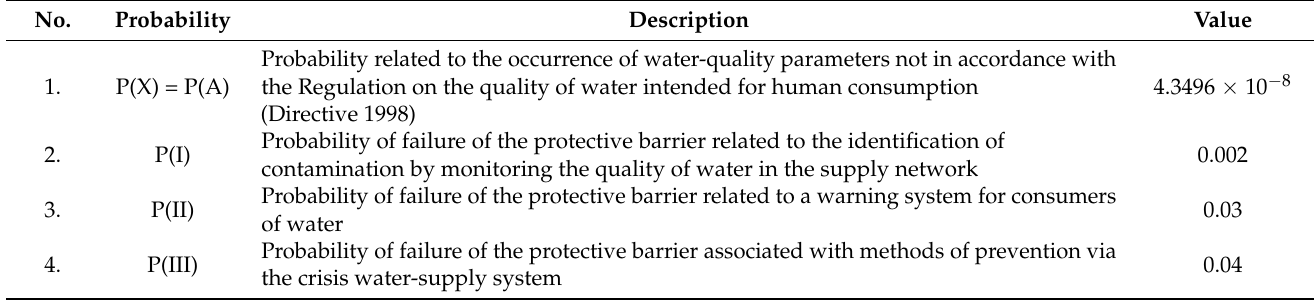
Table 3. Individual probabilities of secondary pollution of water in a supply